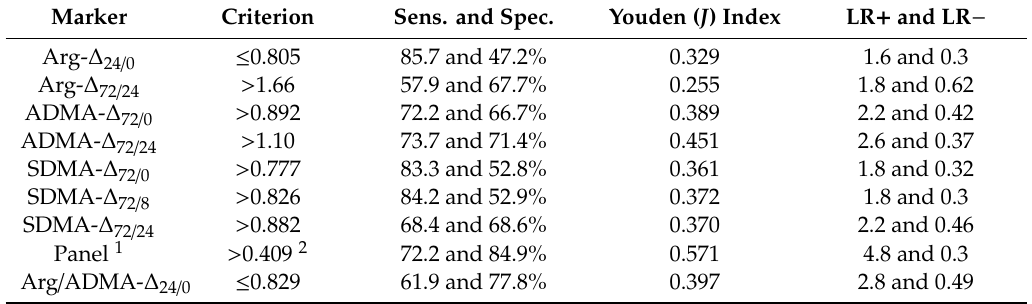
Table 13. Characteristics of L-arginine / NO pathway metabolites as predictors of postoperative ileus. Marker Criterion Sens. and